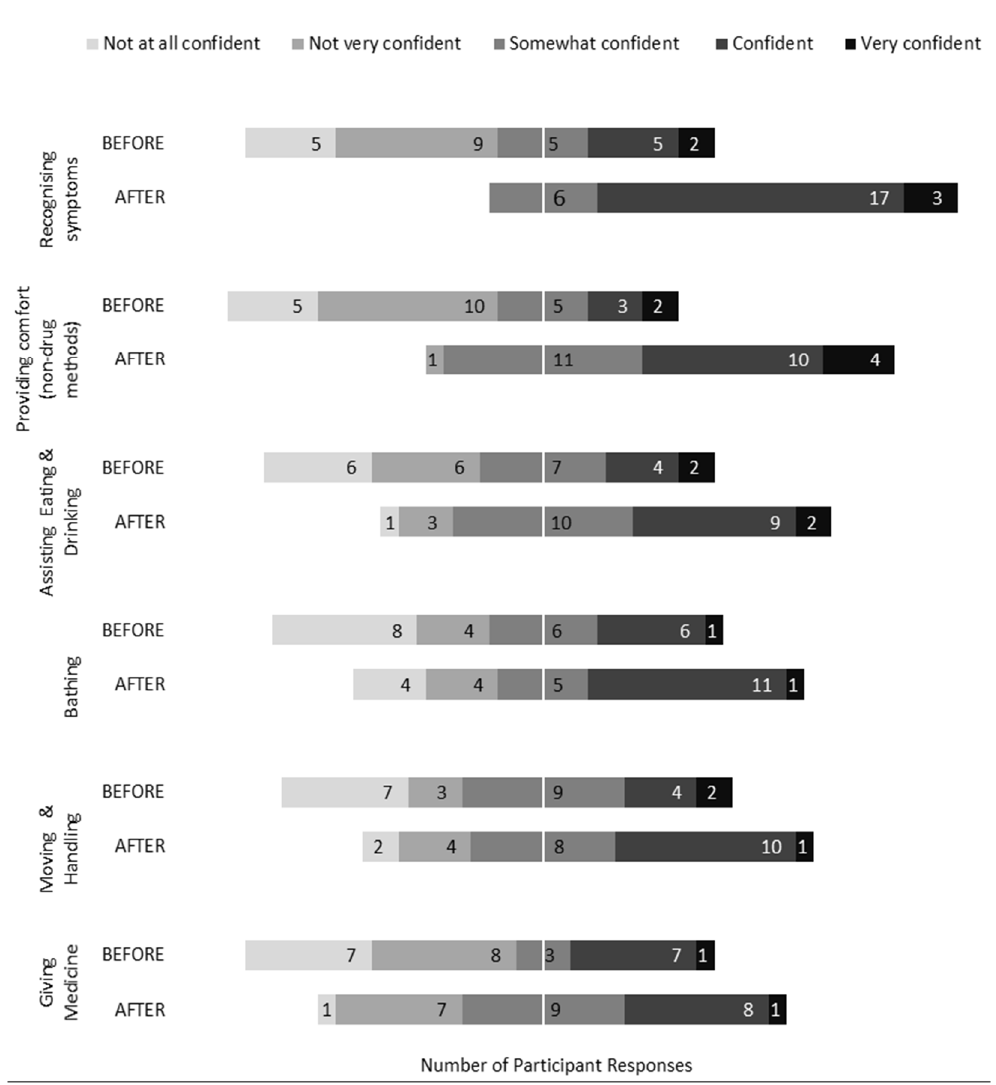
Figure 4. Confidence in supporting care of people dying.